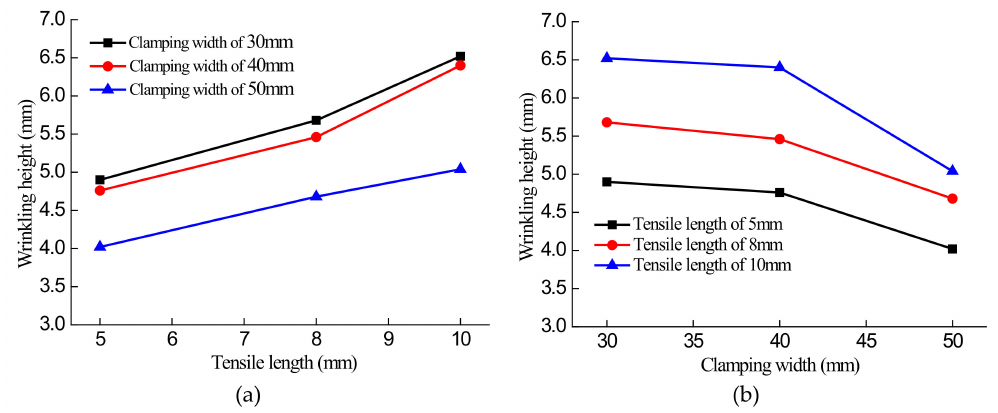
Figure 15. Test curves for wrinkling height: ( a ) Wrinkling height versus tensile length for di ff erent clamping widths; ( b ) wrinkling height versus clamping width for di ff erent tensile